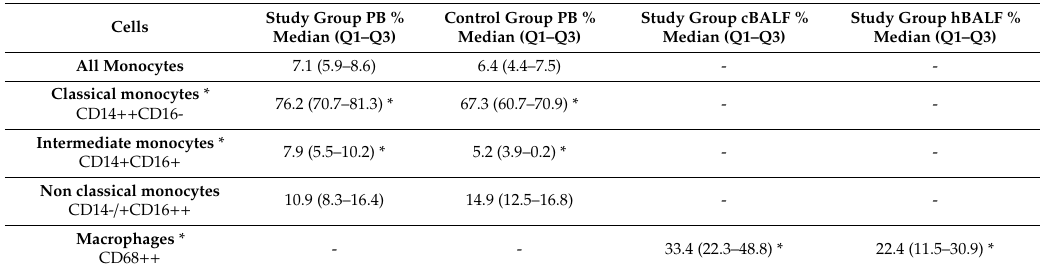
Table 2. Median proportion of tree types of monocytes in study and control groups and BALF